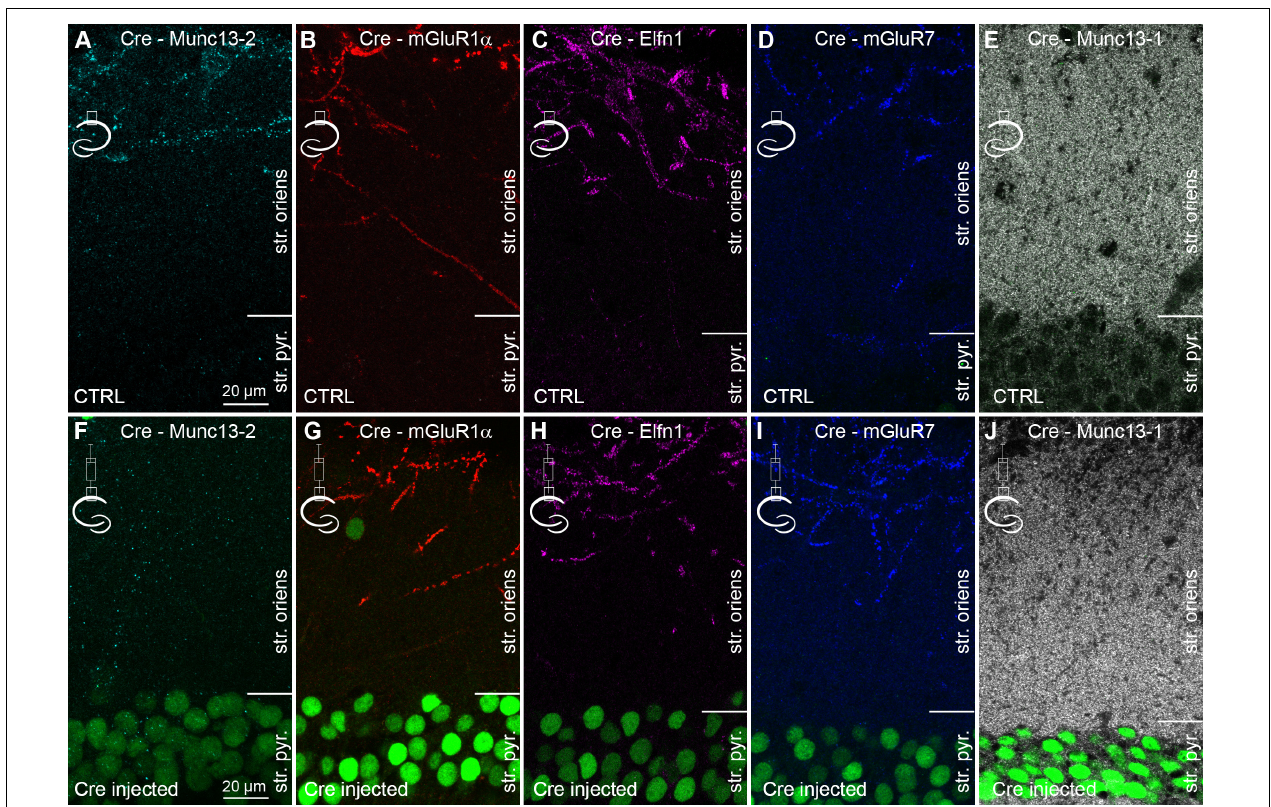
FIGURE 3 | Conditional knock-out of Munc13-2 does not change the expression and distribution of Elfn1 and mGluR7. (A–E) Double immunolabeling for Cre and either Munc13-2 (A) or mGluR1 α (B) , or Elfn1 (C) or mGluR7 (D) or Munc13-1 (E) in the dorsal CA1 area of the non-injected hemisphere. (F–J) Same as in (A–E) , but the images are from the hemisphere that has been injected with AAV expressing Cre-recombinase. Immunolabeled Cre (green) is visible in most CA1 PC nuclei (green). Note the lack of immunolabeling for Munc13-2 in the outer part of the stratum oriens, demonstrating the efficient removal of the protein, while there is no detectable change in the immunolabeling for mGluR1 α , Elfn1, mGluR7, and Munc13-1. Maximum intensity projection of 4 confocal images separated by 1 µ m. str. pyr, stratum pyramidale; str. oriens, stratum